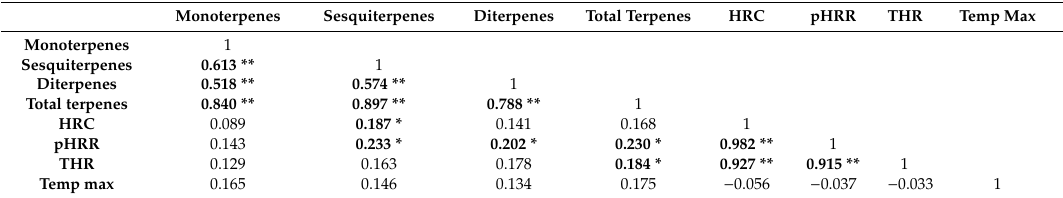
Table 2. Table showing Pearson correlations between terpene and flammability measurements for fresh needles across all seasons (n = 117). Significant correlations are in bold and the level of significance is indicated with asterisks (** p < 0.01; * p < 0.05). Monoterpenes Sesquiterpenes Diterpenes Total Terpenes HRC pHRR THR Temp Max